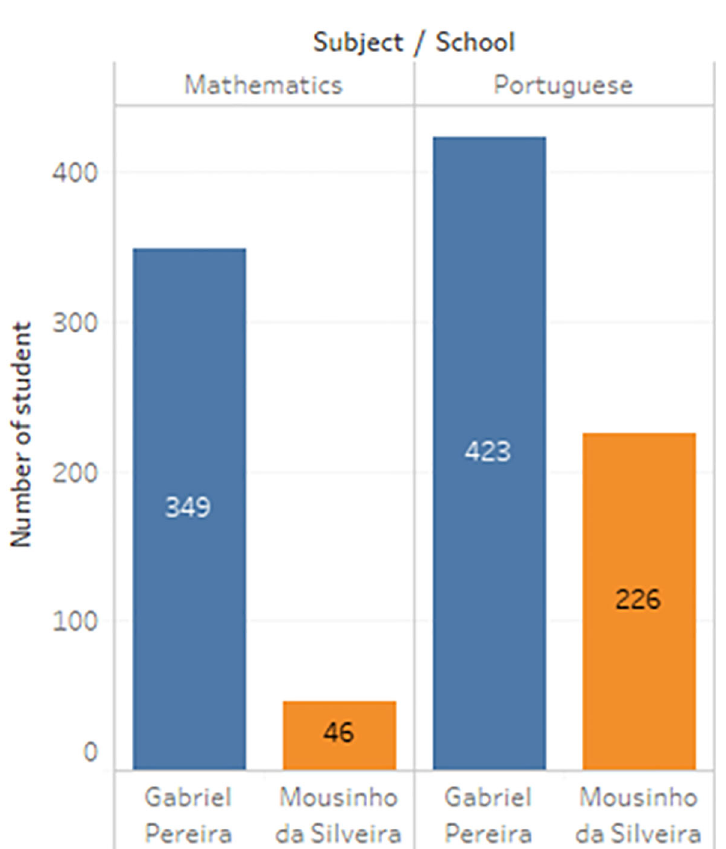
Figure 4. Distribution of subject.